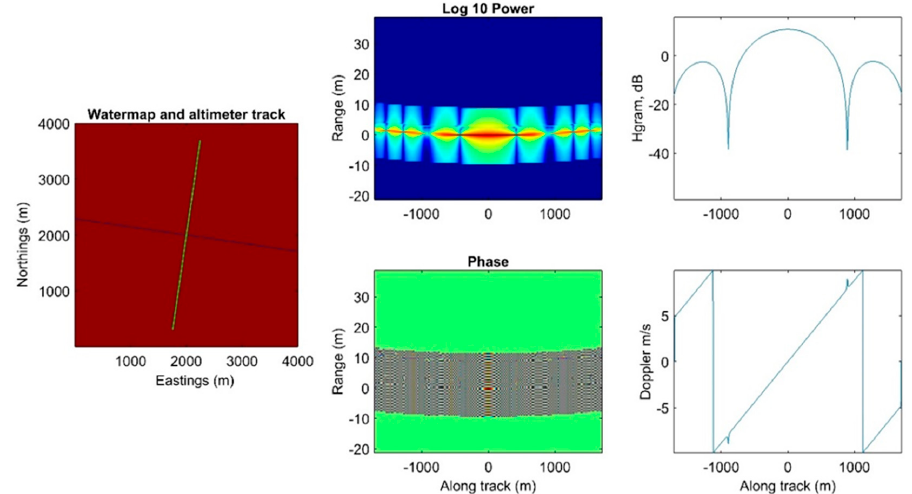
Figure 3. Model for the narrow river example (dimension is approximately 10 m).